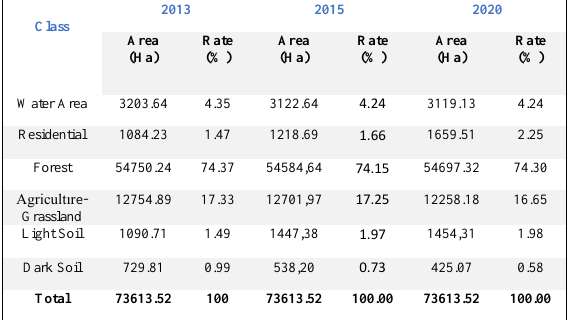
Figure 4. Land Use Maps